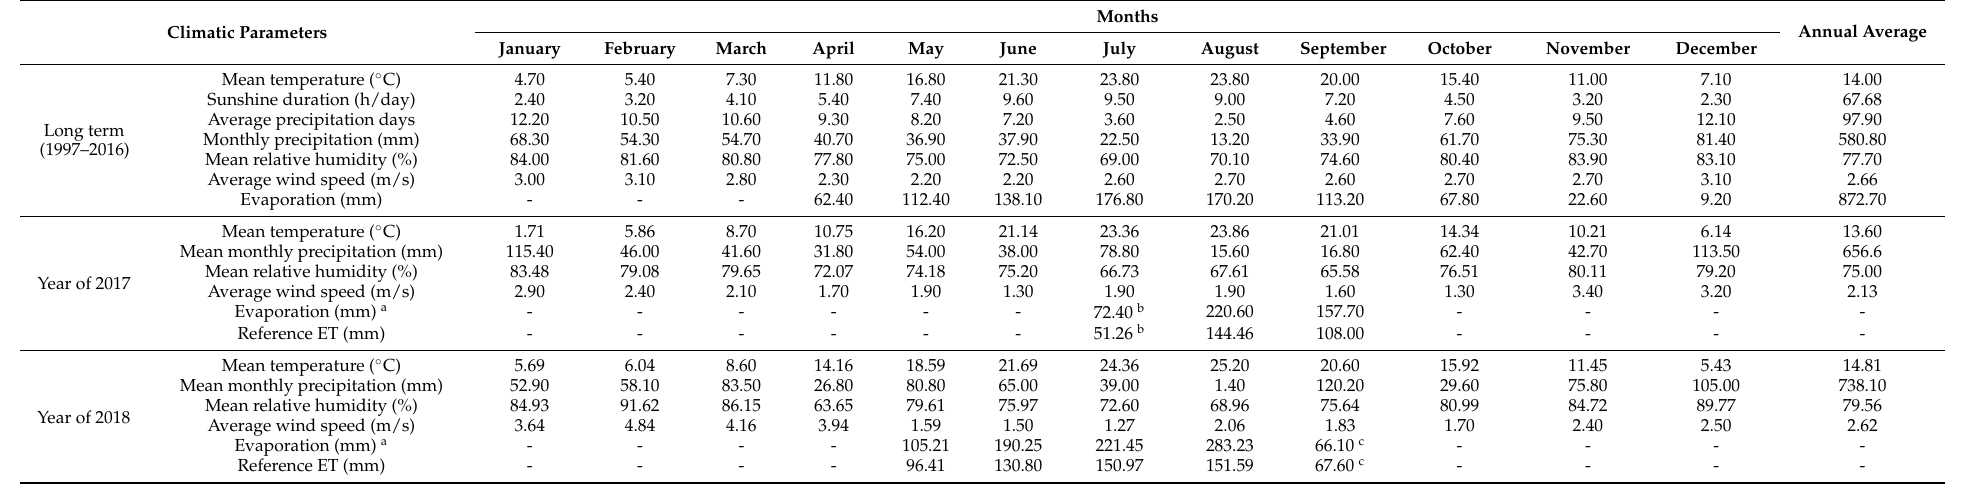
Table 1. Monthly climatic parameters for long term (1997–2016) and experimental years. Climatic